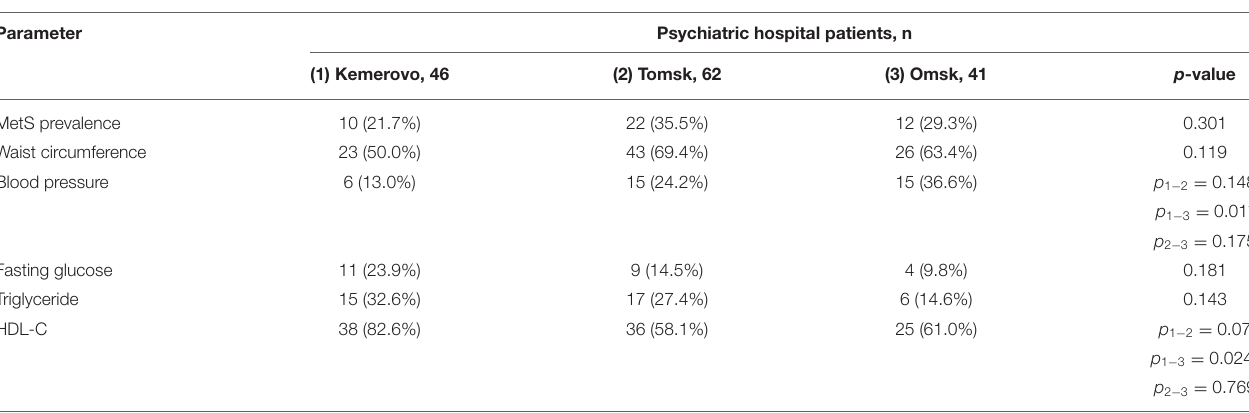
TABLE 12 | Prevalence of MetS and its criteria in the female part of the study population [ n (%)].